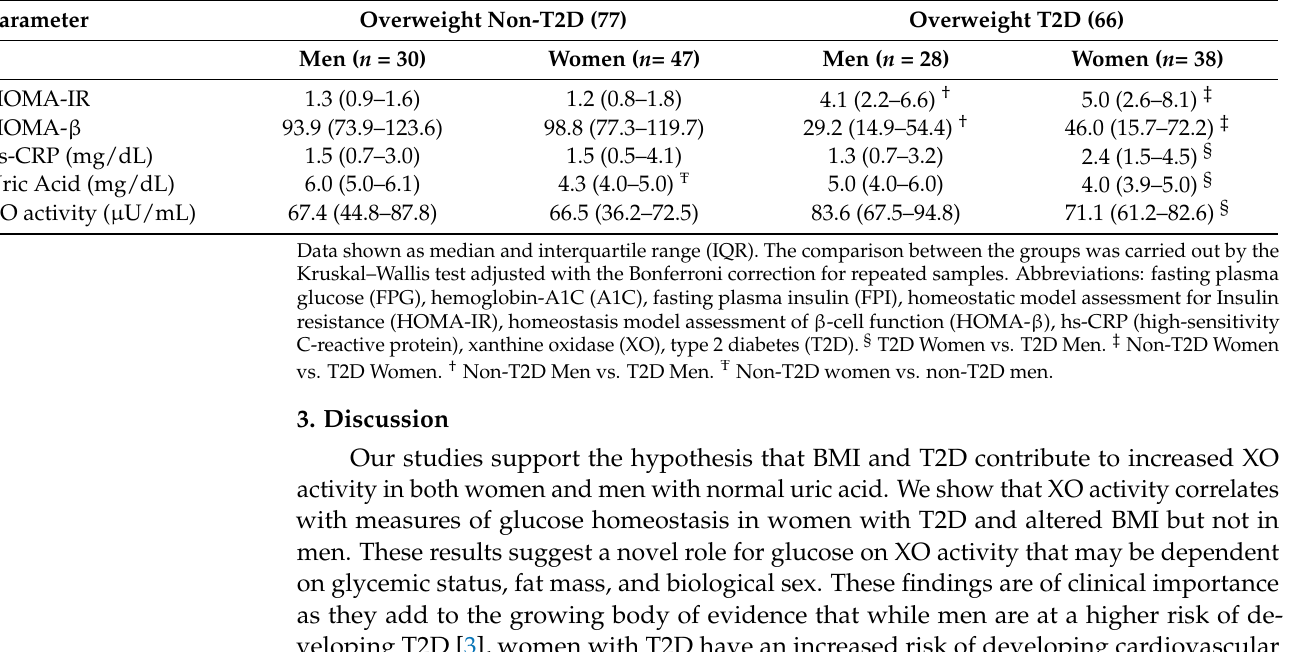
Table 2. Sex-based analyses of overweight T2D patients and non-T2D subjects.